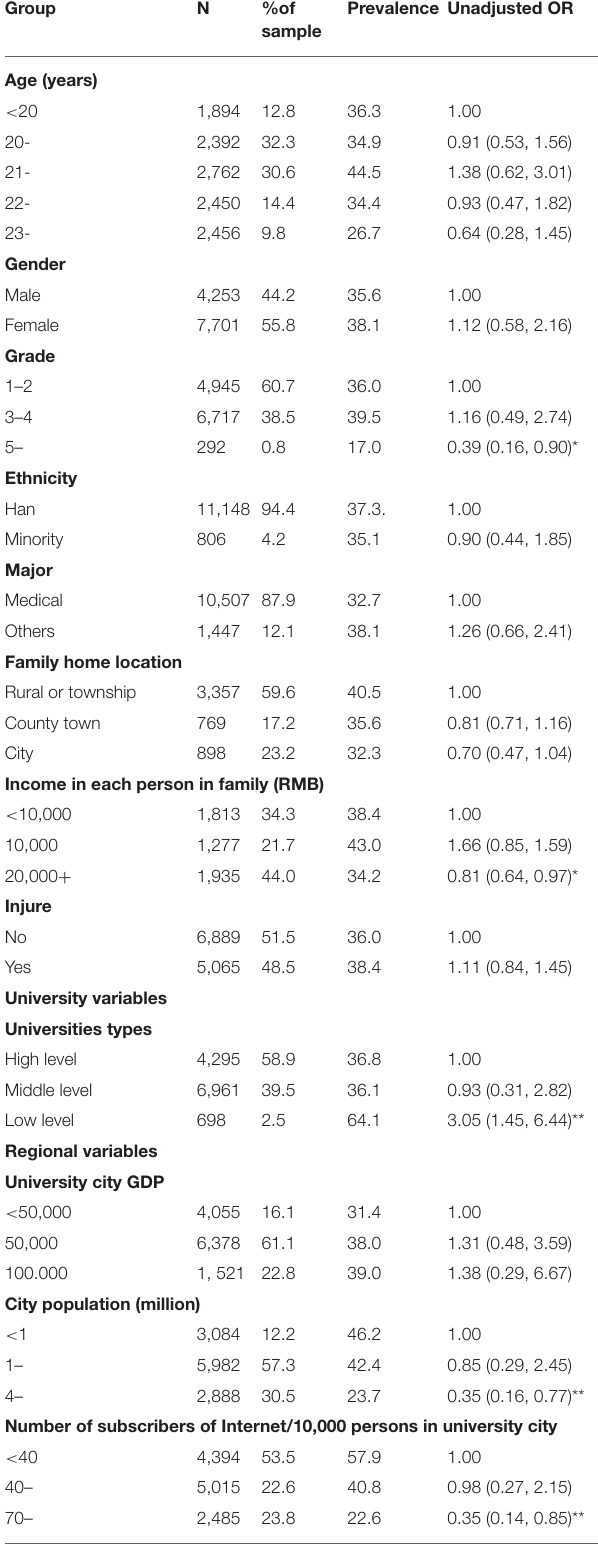
TABLE 1 | Demographic characteristics of sample and mental stress prevalence.